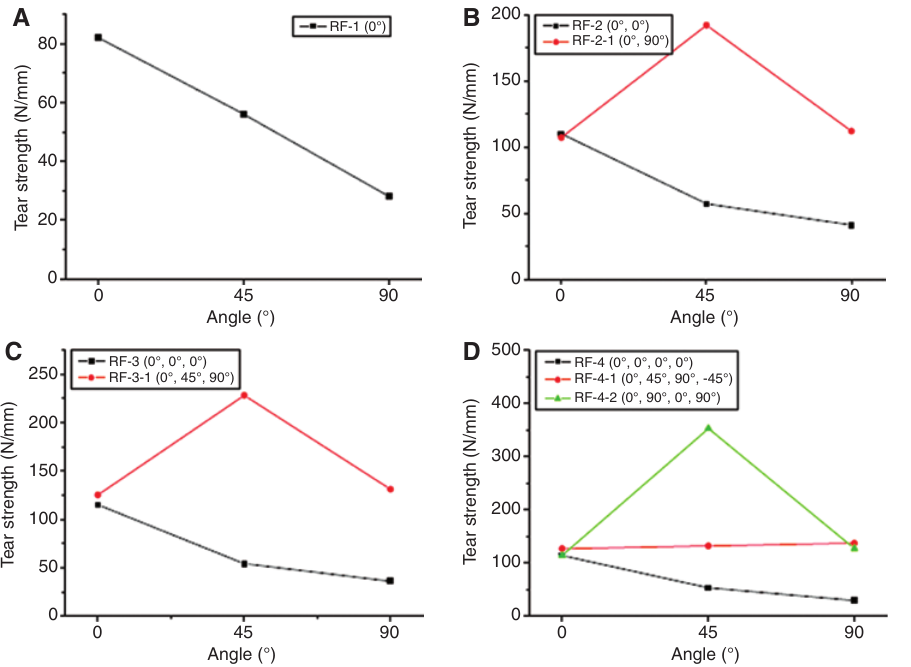
Figure 8: (A)–(D): Tear strength at various angles of CR composites with different numbers of tire cord layers and arrangement